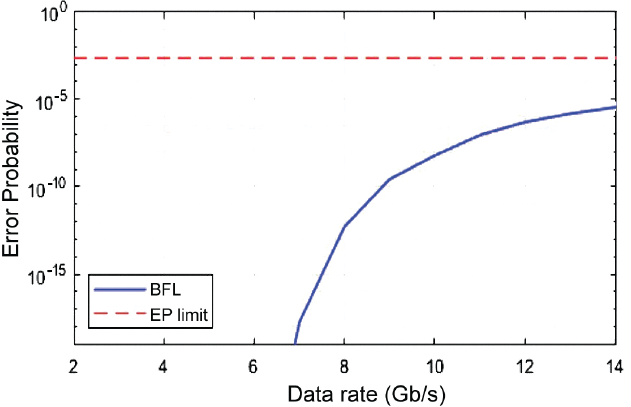
Figure 8. Error Probability ( EP ) vs. RSOA direct modulation data rate. EP limit is set to the corresponding FEC value of 3.8 × 10 − 3